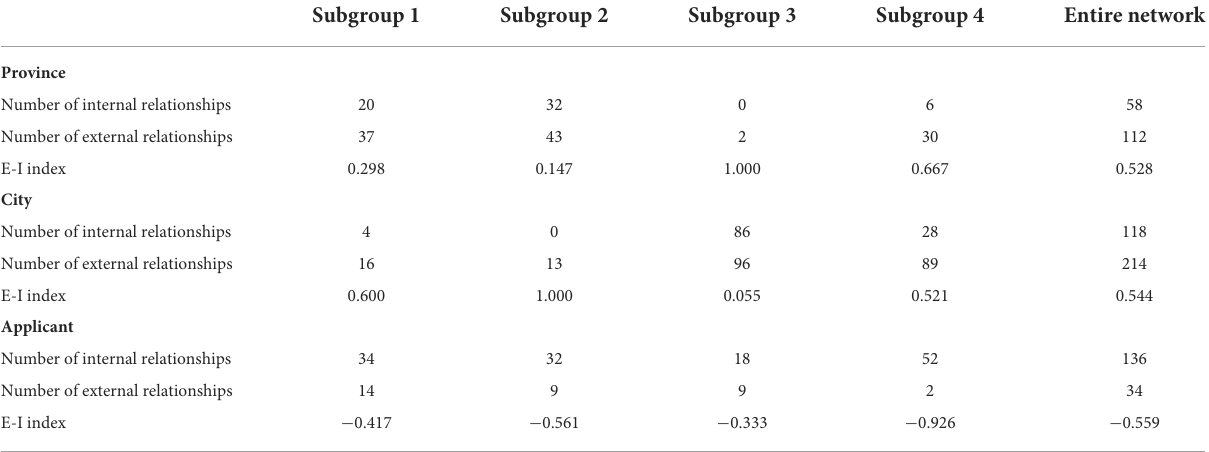
TABLE 6 E-I index analysis of the COVID-19 patent cooperation networks. Subgroup 1 Subgroup 2 Subgroup 3 Subgroup